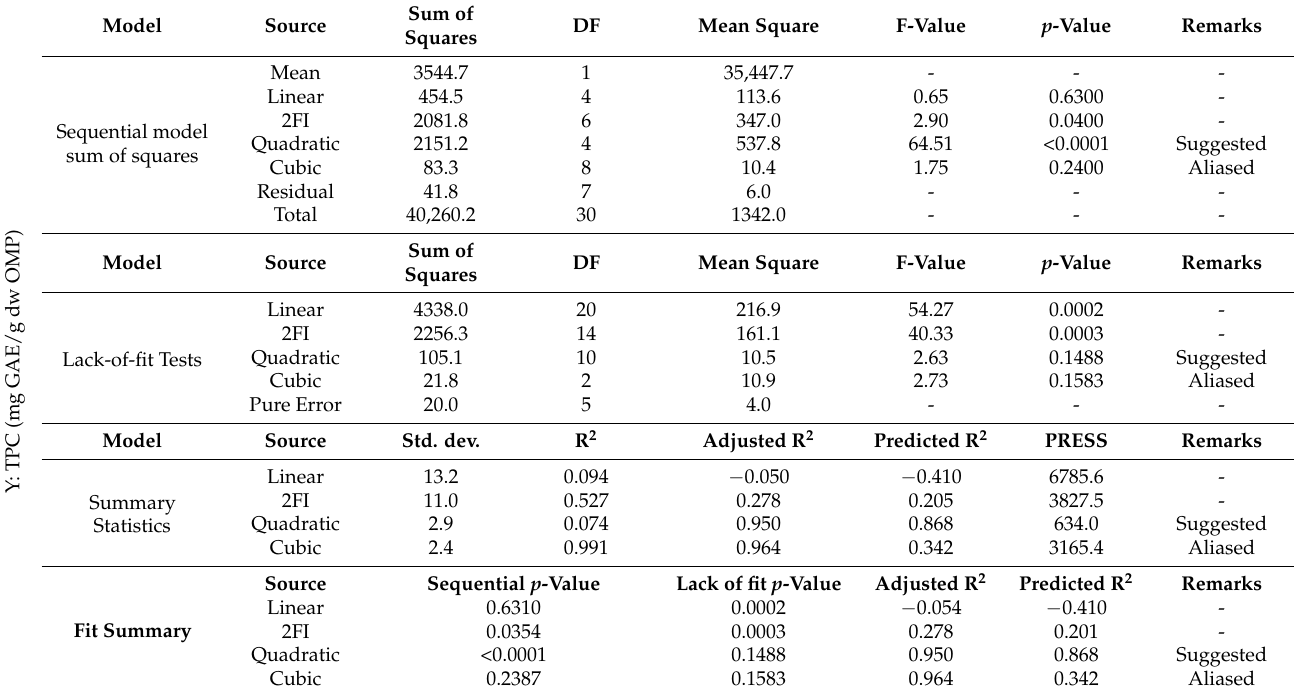
Table 2. Sequential modelfitting forthe extractionof phenolicantioxidants from olivemill